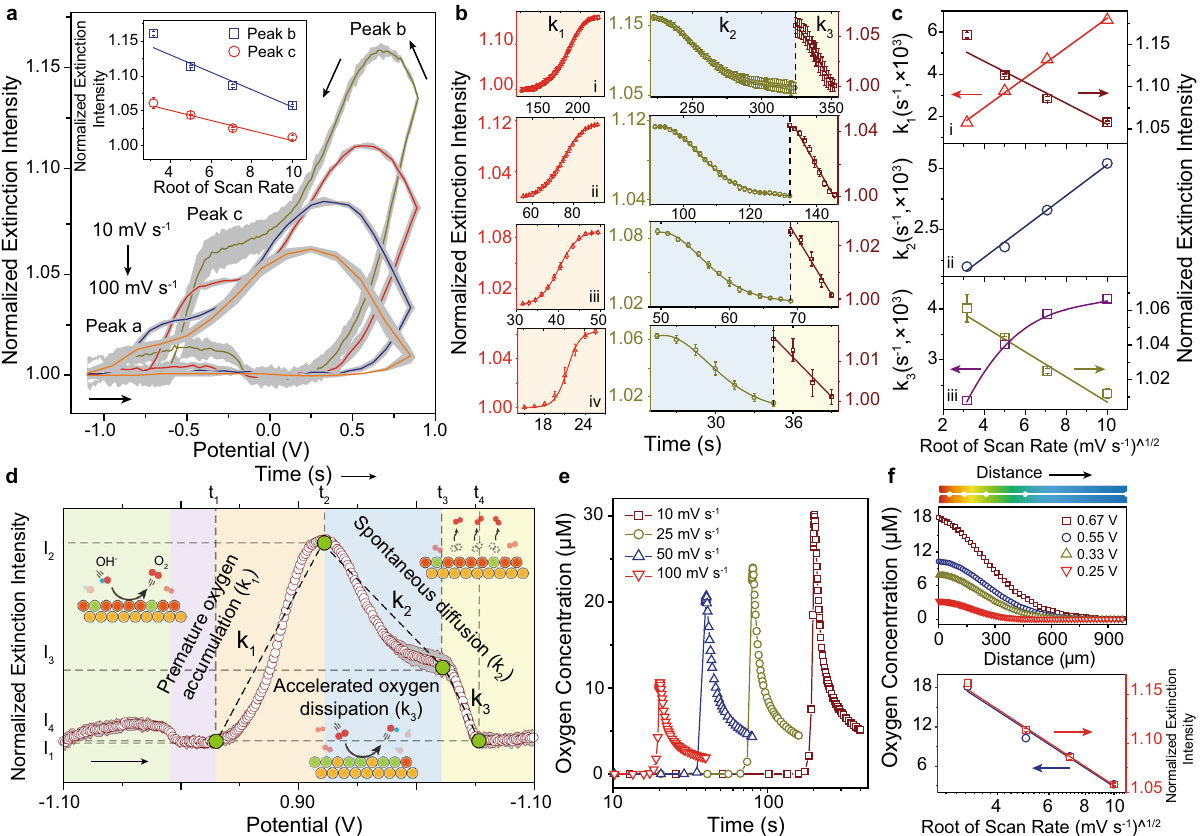
Fig. 4 Kinetic analysis of multistage oxygen diffusion at the EEIs. a The scan rate-dependent behavior for extinction voltammetry. Inset shows the relationship between extension intensity (peak b and c ) and the square root of the scan rate. The dark region represents the SE during consecutive fi ve scans. b The extinction intensity evolution during oxygen diffusion and oxygen reduction region at various scan rates 0.01, 0.025, 0.05, and 0.10 V s − 1 (i – iv). c The oxygen accumulation rate k 1 compared with peak b (i), the oxygen diffusion rate k 2 (ii), and oxygen reduction rate k 3 compared with peak c as a function of the square root of the scan rate (iii). Error bar in b and c represents the SE during consecutive fi ve scans. d Schematic of apparent oxygen accumulation rate k 1 ( k 1 = ⎸ I 2 − I 1 ⎹ ( t 2 − t 1 ) − 1 ), oxygen diffusion rate k 2 ( k 2 = ⎸ I 3 − I 2 ⎹ ( t 3 − t 2 ) − 1 ), and dissipation rate k 3 ( k 3 = ⎸ I 4 − I 3 ⎹ ( t 4 − t 3 ) − 1 ) during dynamic potential scan. Inset shows the interfacial reactions. e Numerical simulation of oxygen concentration evolution on the electrode surface at various potential scan rate (0.01, 0.025, 0.05, and 0.10 V s − 1 ). f Numerical simulation of concentration pro fi les at various polarization potential corresponding to the peak potential (peak b ) at various scan rates 0.01, 0.025, 0.05, and 0.10 V s − 1 , respectively (top panel). The comparison between the dependence of oxygen concentration at the EEIs and extinction intensity (peak b) on the square root of the scan rate (bottom